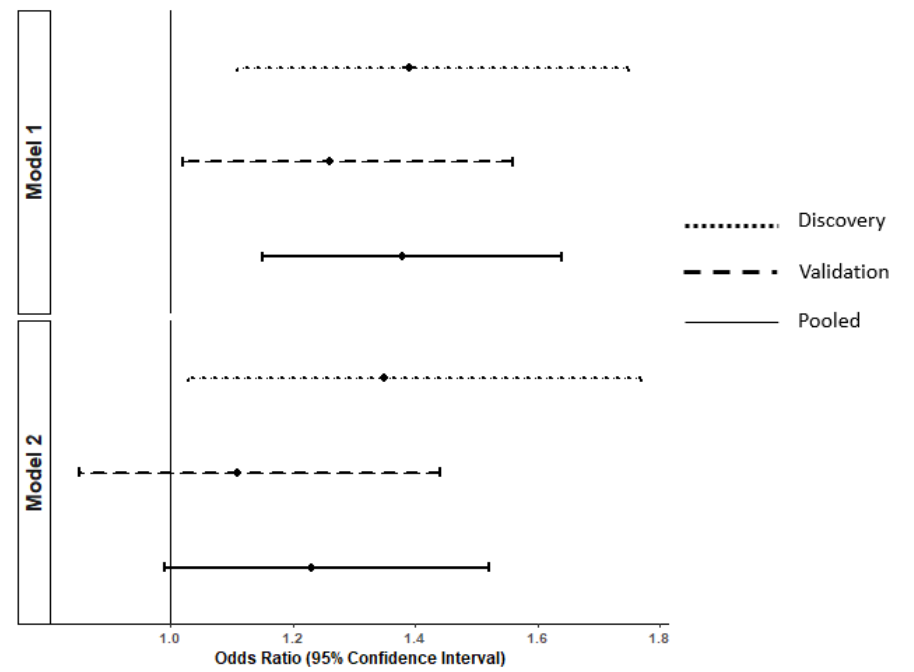
Figure 1. Multivariable-adjusted associations 1 between standardized concentration of propionic acid in serum and the odds of subsequent cognitive decline over 12 years in the discovery ( n = 418), validation ( n = 420) and pooled samples ( n = 838). 1 Estimated using conditional logistic regressions (conditioned using matching variables, i.e., age, sex and educational level). Model 1: adjusted for potential confounders (alcohol consumption and smoking). Model 2: adjusted for confounders (alcohol consumption and smoking) and potential mediators (body mass index, hypertension, hyper- cholesterolemia, and